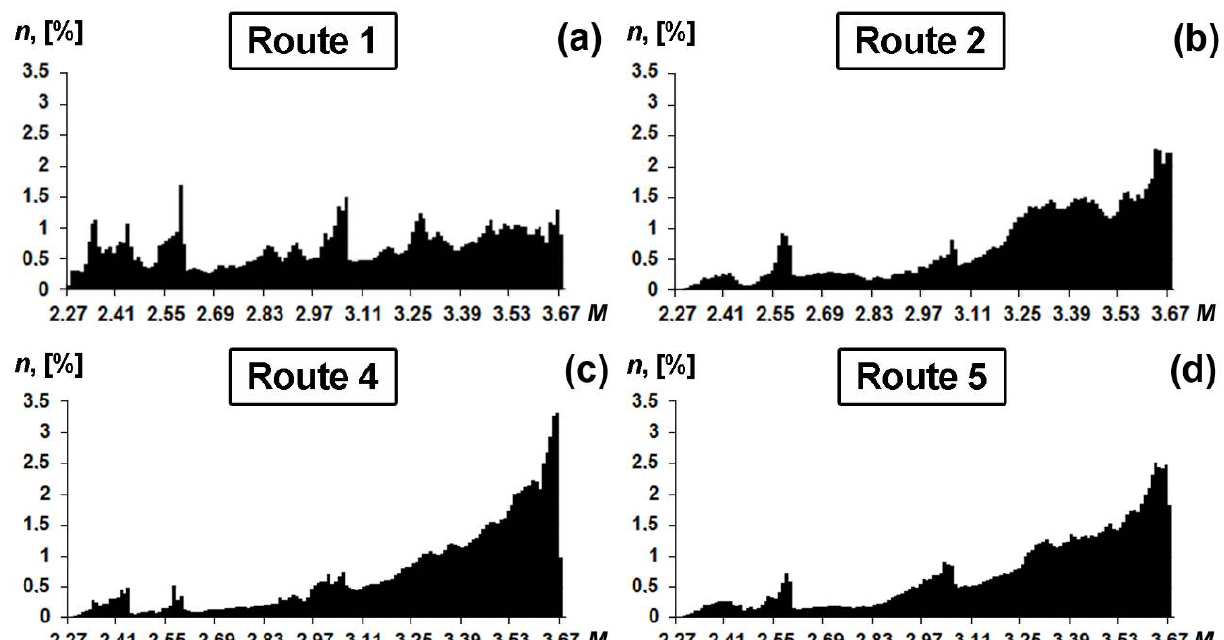
Table 2. Averaged Taylor factors of the central areas of the pipeline steel plates after TMCP. Route